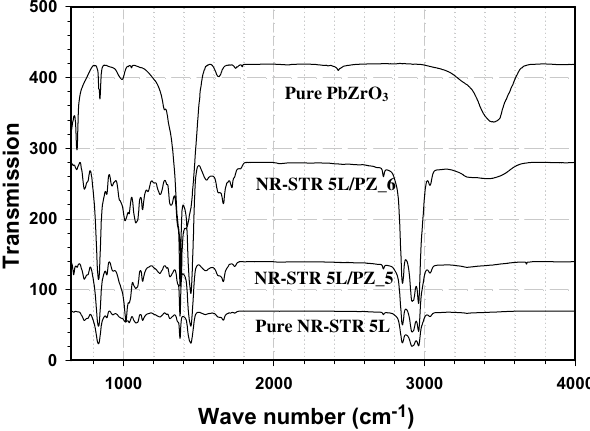
Fig. 1. FTIR spectra of natural rubber (NR-STR 5L), lead zirconate (PbZrO 3 Þ , NR-STR5L/PZ 5, and NR-STR5L/PZ 6 composite